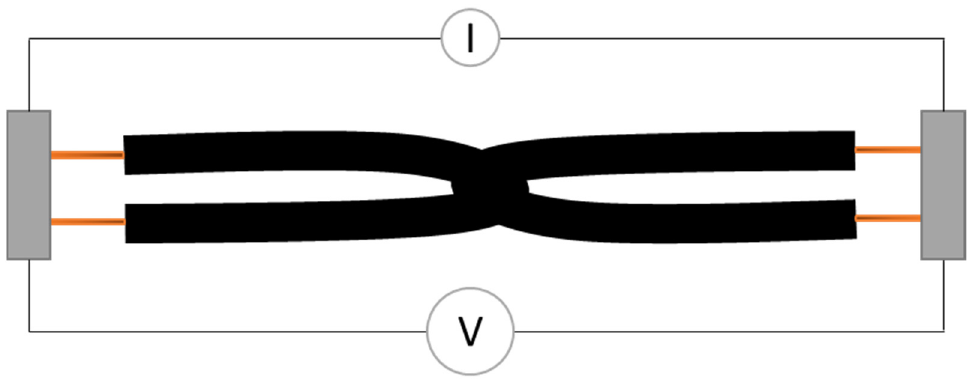
Figure 3. Schematic drawing of four-point probe method carried out at the interlooped hybrid yarns.